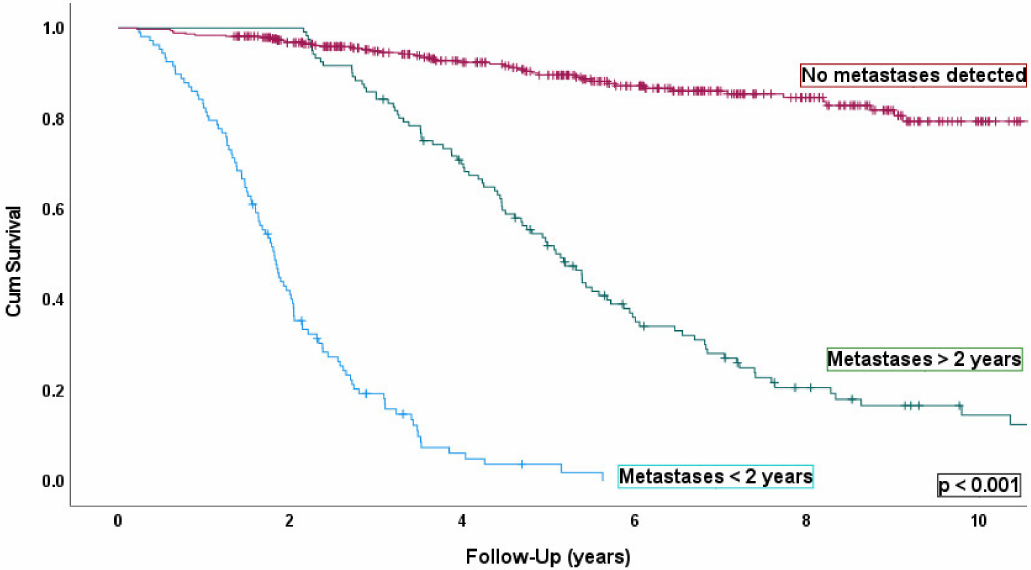
Figure 4. Kaplan–Meier survival curve and table where all the patients were stratified according to when and whether developed metastases; Group1—patients diagnosed with metastases < 2 years ( n = 108) ( p < 0.001); Group 2—patients diagnosed with metastases after 2 years ( n = 121) ( p < 0.001); and Group 3—patients who had not been diagnosed with metastases at study closure ( n = 386) ( p < 0.001). Number of events indicates the number of